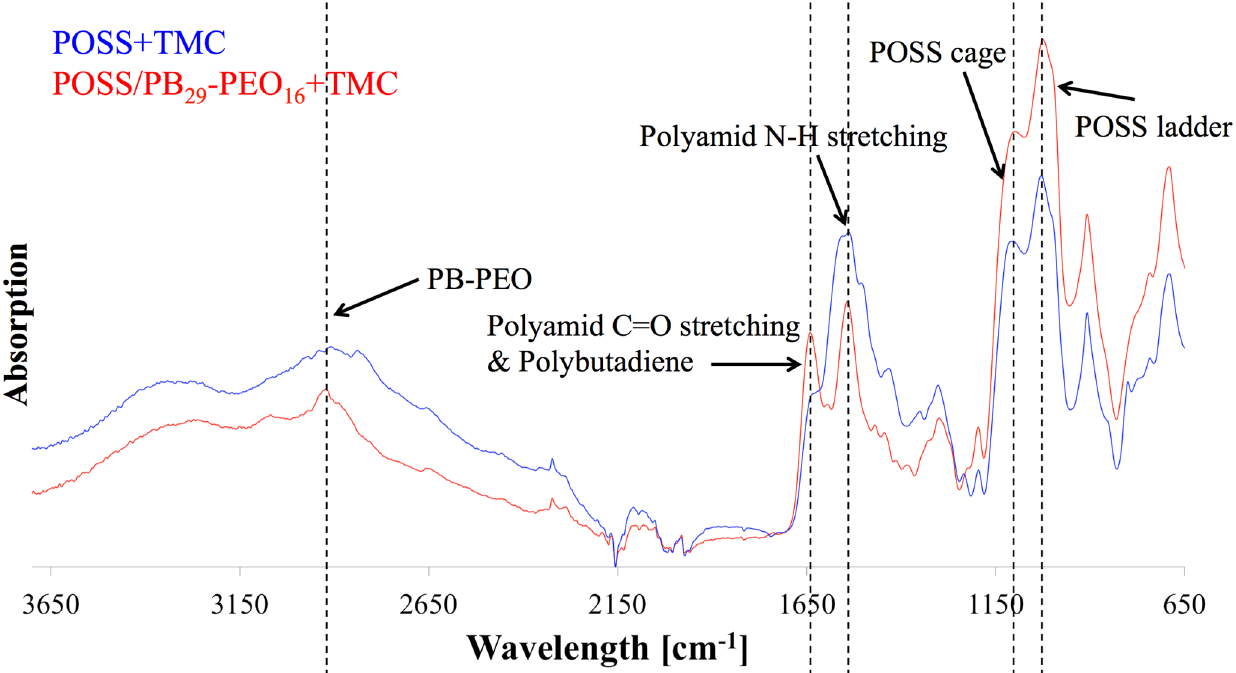
Figure 10. FTIR diagram of POSS/polymersomes+TMC AL (labelled red) and POSS+TMC control AL (labelled blue) as a function of wavelength against absorption. The AL with polymersomes had an absorption peak around 3000 cm − 1 , that responds to PB and PEO, indicating their presence in the AL, where the characteristic absorption peaks for PA bonds and POSS were present as